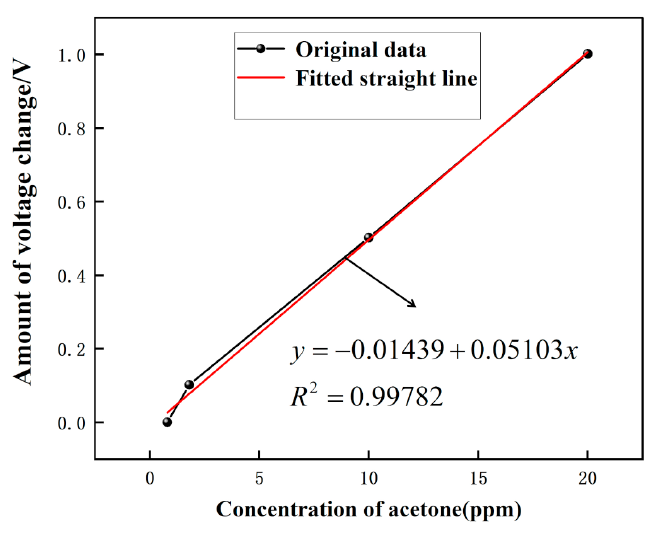
Figure 19. The voltage variation graph for different acetone concentration environments.